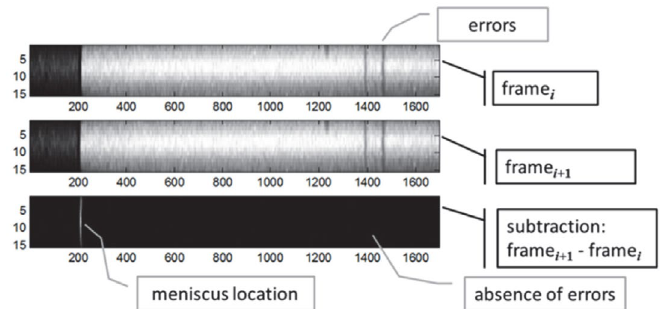
After the microchannel centers were known, each channel was identified as a region of interest (ROI) deter- mined by the boundary indexes in the image matrix, which were calculated from the microchannel centers and chan- nel width.